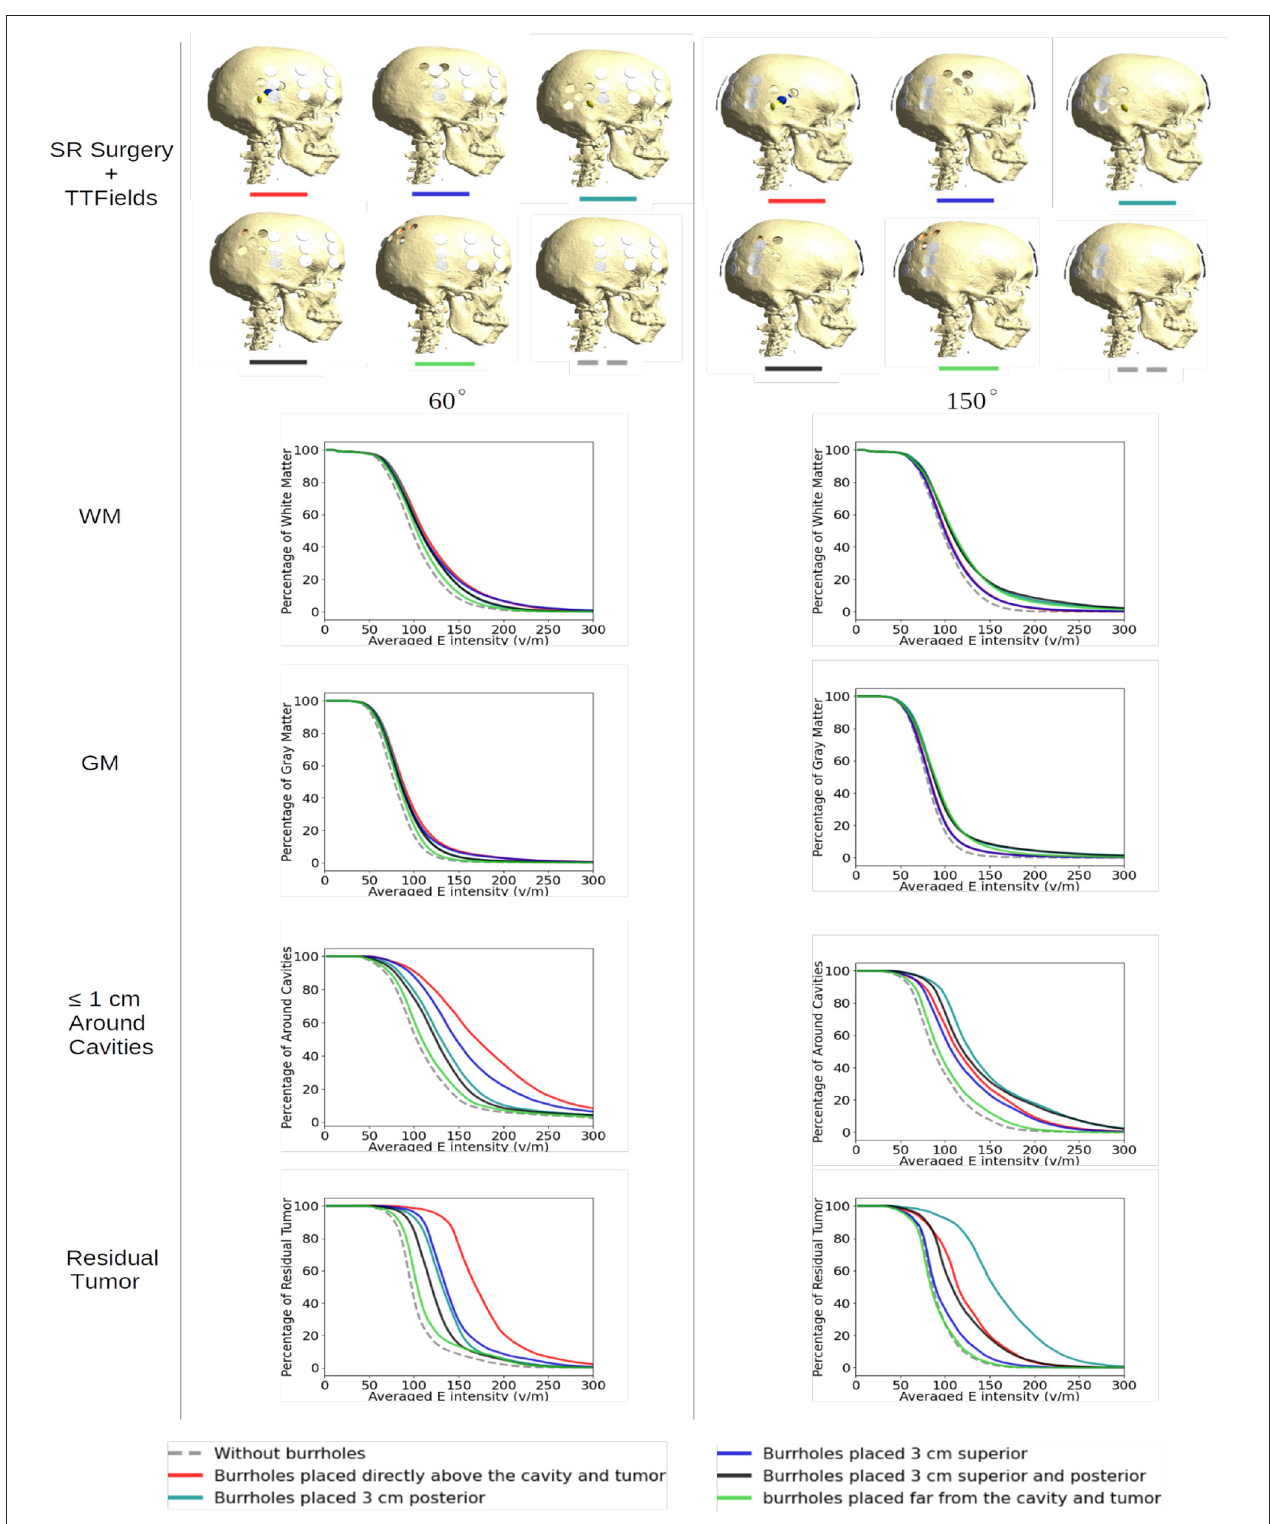
FIGURE 5 | Effect of SR surgery with array positions at 60-degree (optimal) and 150-degree (suboptimal) rotations, respectively, for all configurations of SR surgery and the control without burr holes. The plots show the cumulative distributions of electrical field intensities obtained with burr holes over the resection cavity (red lines), the four alternative placements (other solid lines), and without burrholes (dashed gray lines). The cumulative distributions in the y -axis are given as the percentages of WM, GM, peri tumor, and residual tumor exposed to field intensities above the corresponding values on the x -axis.